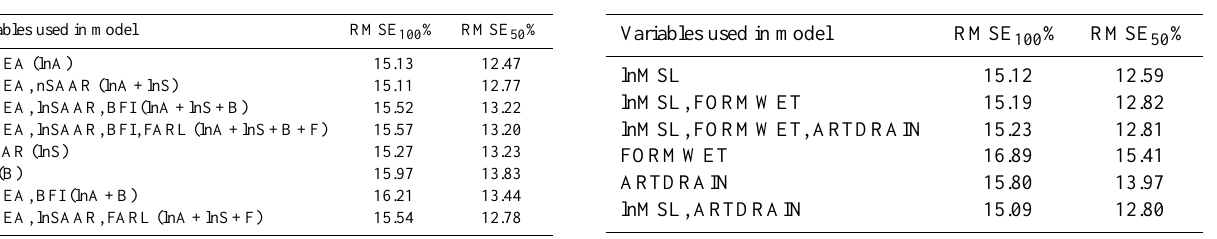
Table 2. Variation in the mean RMSE corresponding to T =100 and 50 for different sets of pooling variables: variables as used in FEH (1999).